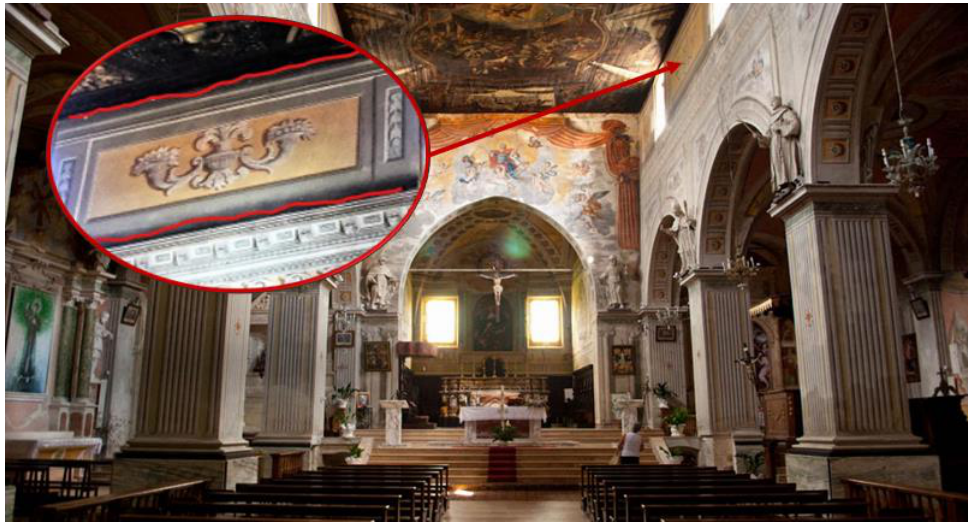
Figure 16. The dome in St. Savino church in Gualdo, before ( a ) and after ( b ) the earthquake occurred